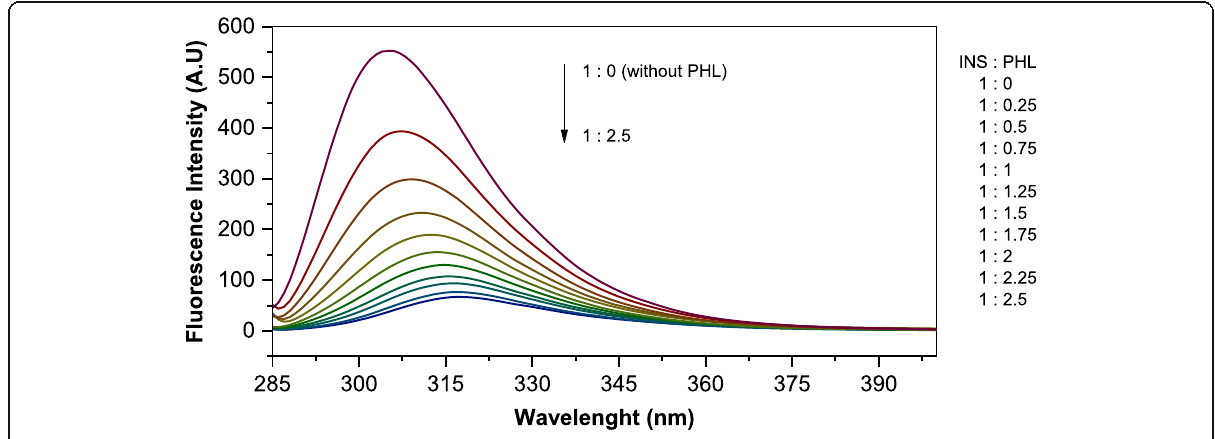
Fig. 3 The fluorescence intensity of INS and PHL in 288